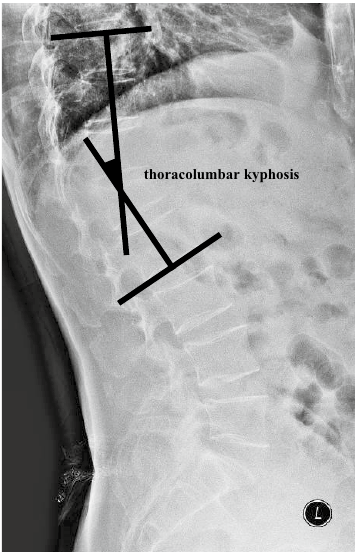
Figure 1. Measurement of thoracolumbar kyphosis. After the vertebral bodies of T10 and L2 were identified, a line was drawn overlapping the upper endplate of T10, and another line was drawn overlapping the lower endplate of L2; the angle between the two lines represented the degree of thoracolumbar